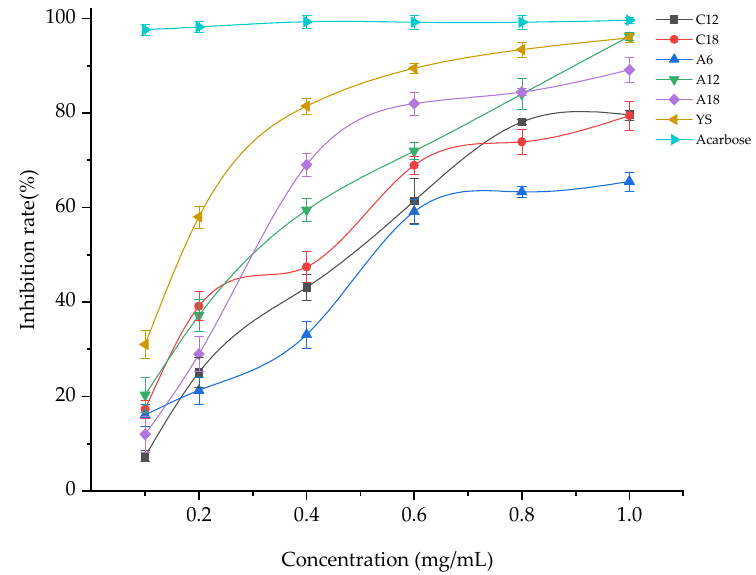
Figure 6. Inhibition rate of α -glucosidase activity variation with extract concentration (C12 and C18 represented agarwood produced by A. crassna after 12 and 18 months of inoculation, respectively; A6–A18 represented agarwood produced by A. sinensis after 6, 12, and 18 months of inoculation, respectively; YS represented wild agarwood).